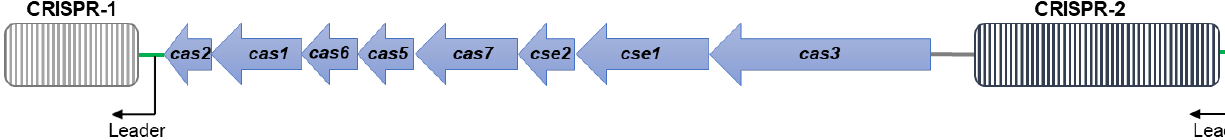
Figure 2. Schematic representation of the clustered regularly interspaced short palindromic repeats (CRISPRs) in S . Typhimurium DT4 (LT2), DT104, and DT104b. The eleven studied S . Typhimurium strains harbour two CRISPR loci, CRISPR-1 and CRISPR-2. The type I-E CRISPR/Cas system is encoded by an operon harbouring eight cas genes (blue boxed arrows) that are located upstream of CRISPR-1. Each CRISPR locus also contains a leader region (green horizontal lines). The black arrows show transcriptional orientation.